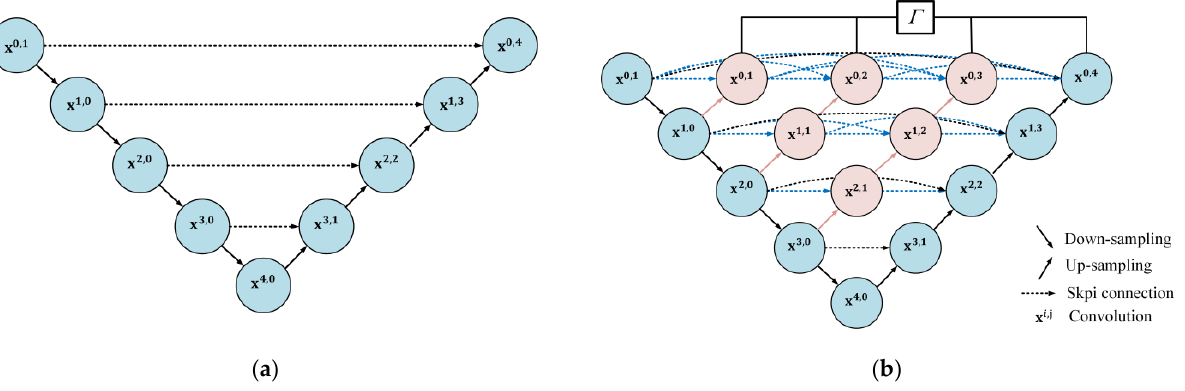
Figure 3. The deep network models for segmentation: ( a ) Unet architecture; ( b ) Unet++ architecture.